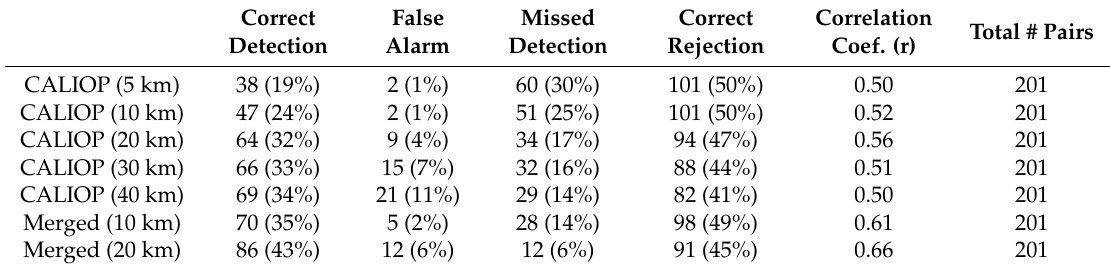
Table 3. Contingency tables and correlation coefficients (r) of ceilometer cloud base heights (CBHs) at KAVL and daytime satellite retrieved CBHs using the following products: averaged CALIOP Level 2 CBHs using 10- and 20-km averaging scales for the CALIOP data, following the method outlined in Figure 2. Values in parentheses are expressed as a percentage of the total number of observation pairs (last column of the table). Note the 5-min window centered over the satellite overpass time is applied to obtain the matched ceilometer CBHs at KAVL.